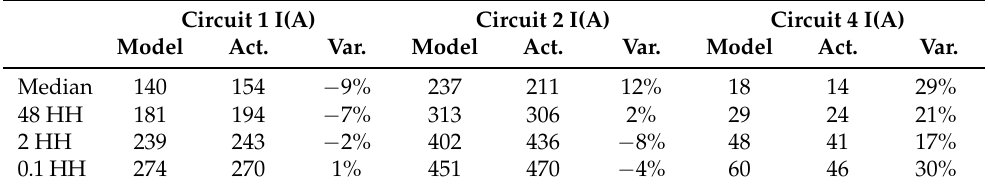
Table 9. Comparison of modelled versus actual (measured) current percentiles for the peak winter week (July), for circuits 1, 2 and